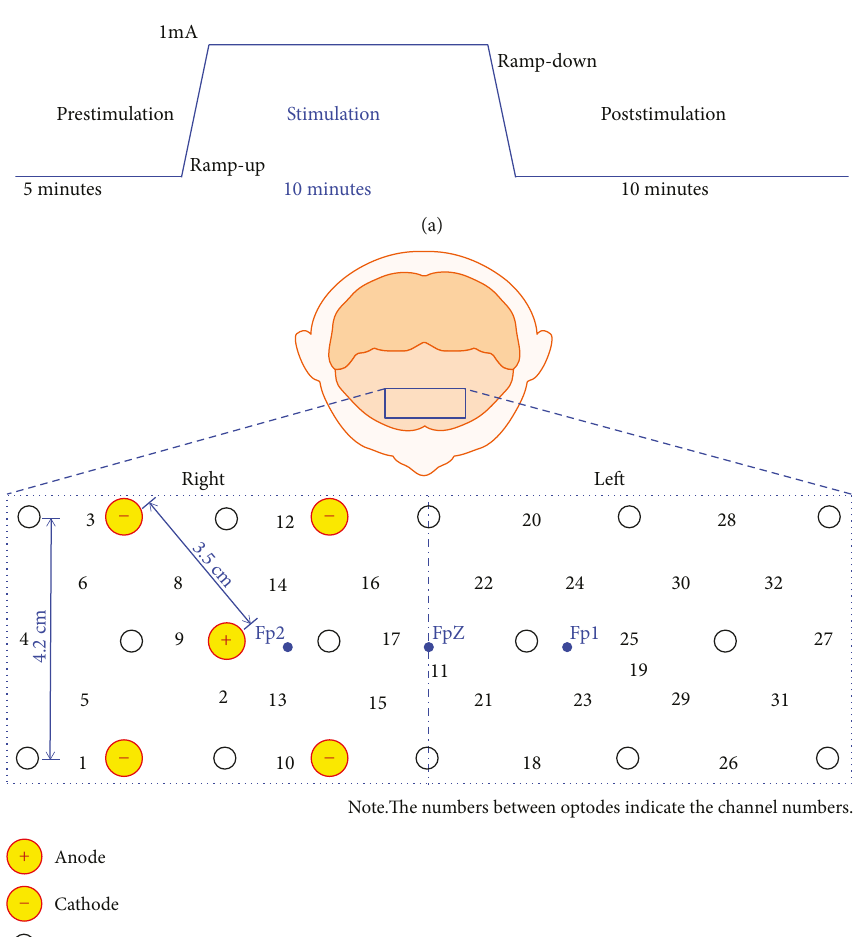
Figure 1: (a) Experimental paradigm and (b) simultaneous arrangement of fNIRS optodes and HD-tDCS